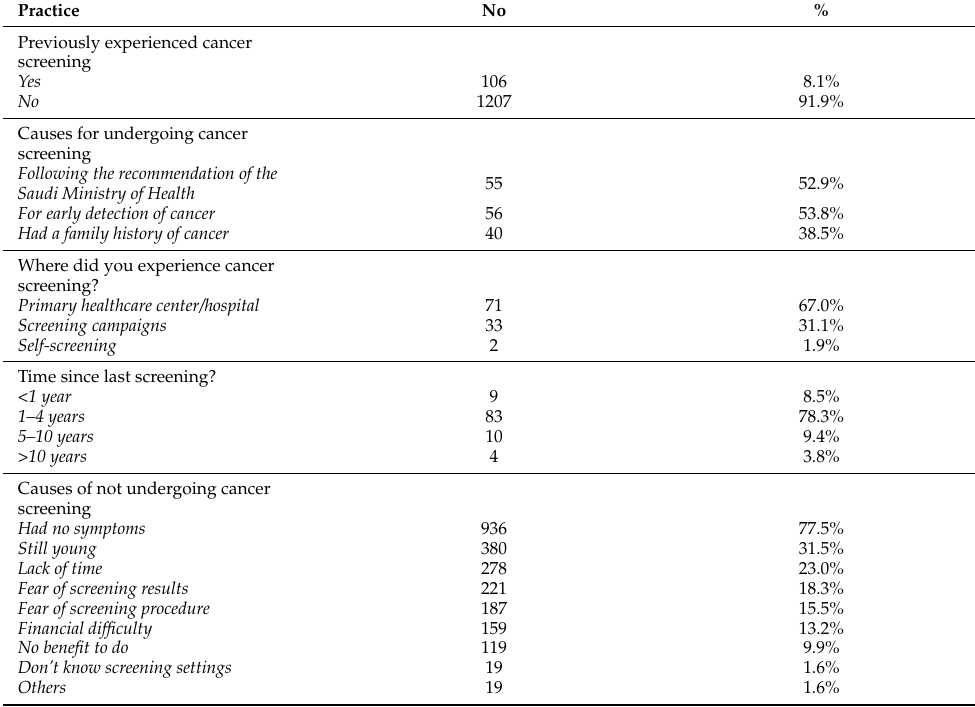
Table 3. Public practice regarding cancer screening, Saudi